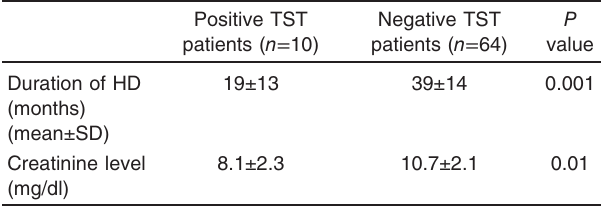
Table 3 Relationship between tuberculin skin test results and duration of hemodialysis and creatinine levels in the studied